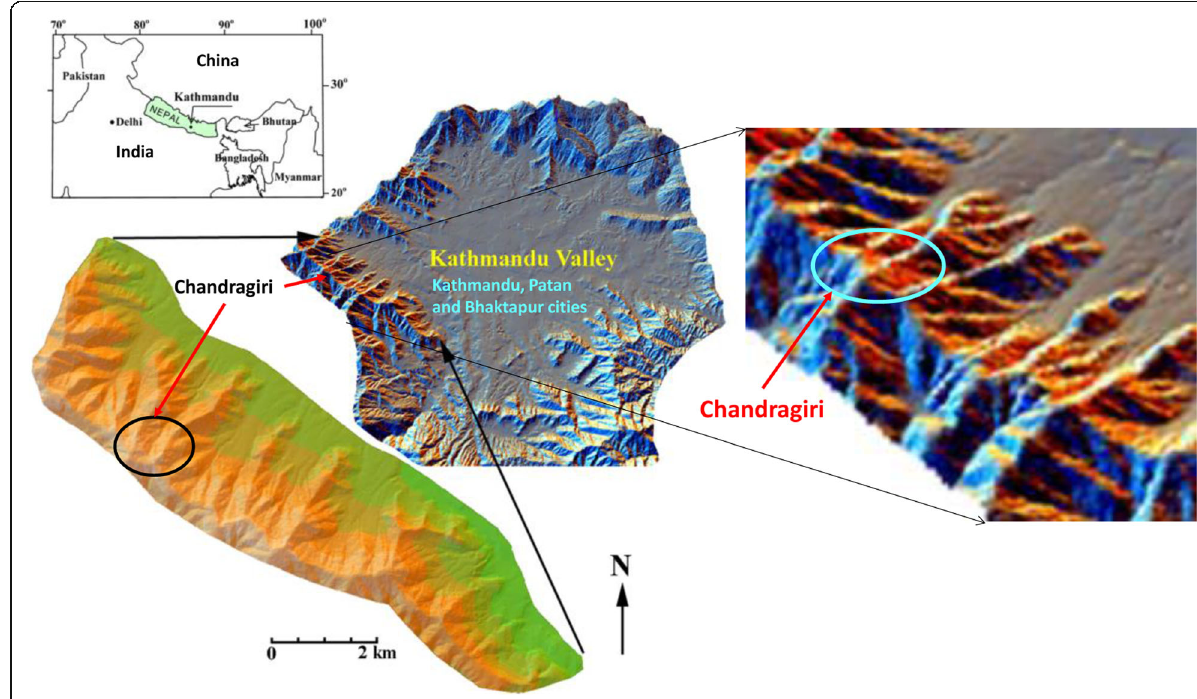
Fig. 1 Location map of the study